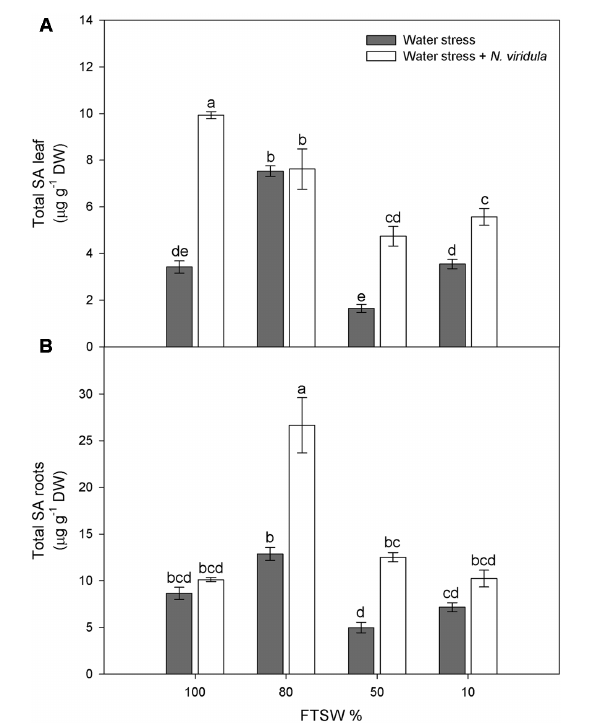
FIGURE 4 | Quantitative measurements ( µ mol g − 1 DW) of H 2 O 2 in well-watered and water-stressed broad bean plants with or without N. viridula infestation. Quantitative measurements of H 2 O 2 in leaves (A) and roots (B) of V. faba plants under developing water stress (gray bars) and with an associated presence of N. viridula infestation (white bars). Measurements were made at 100, 80, 50, and 10% of FTSW. Data are means ± SE ( n = 8). Different letters indicate significant differences ( P < 0.01).